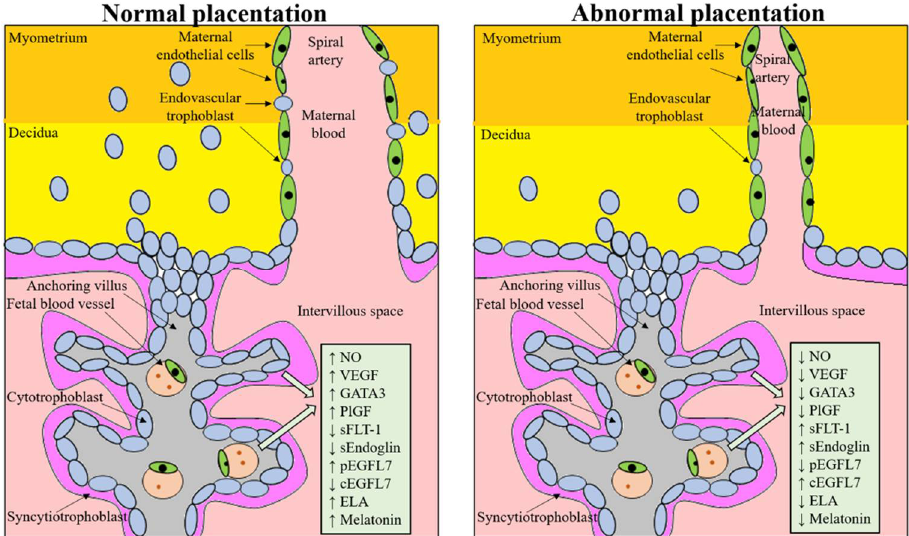
Figure 1. Molecules regulating proper placental development, whose dysregulation is involved in an abnormal placental development. NO, nitric oxide; VEGF, vascular endothelial growth factor; GATA3, GATA binding protein 3; PlGF, placental growth factor; sFLT-1, soluble fms-like tyrosine kinase 1; sEndoglin, soluble endoglin; pEGFL7, placental epidermal growth factor-like domain 7; cEGFL7, circulating epidermal growth factor-like domain 7; ELA, elabela.